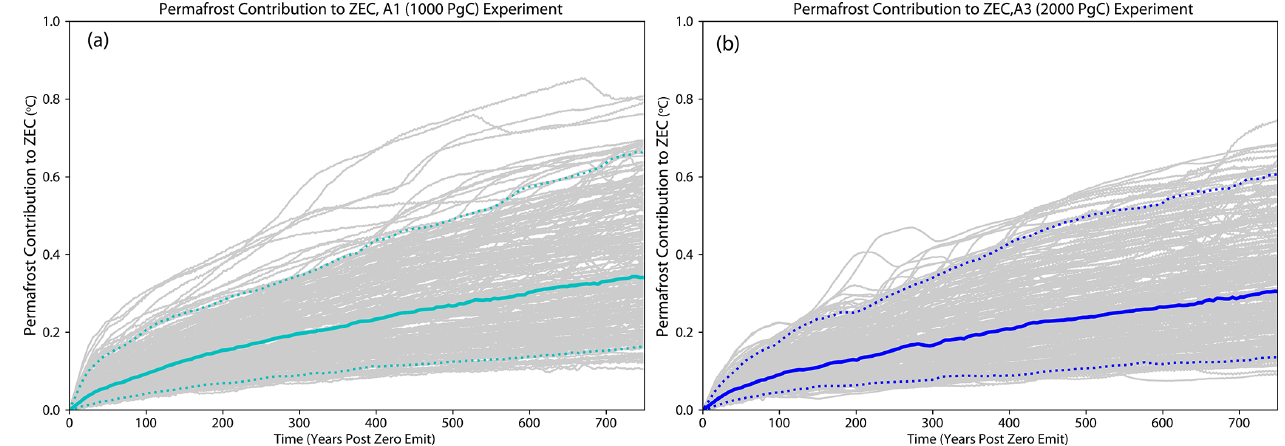
Figure 5. Difference in ZEC between experiments with and without permafrost carbon. (a) Anomalies for the A1 (1000PgC) experiment. (b) Anomalies for the A2 (2000PgC) experiment. Grey lines are individual model variants, solid line is the median of the variants, and dashed lines are the 5th and 95th percentile. Table 2. Median anomalies in ZEC created by release of carbon from permafrost soils, and the magnitude of the respective carbon release. Values in square brackets are 5th to 95th percentile ranges from the perturbed parameter experiments. Years after